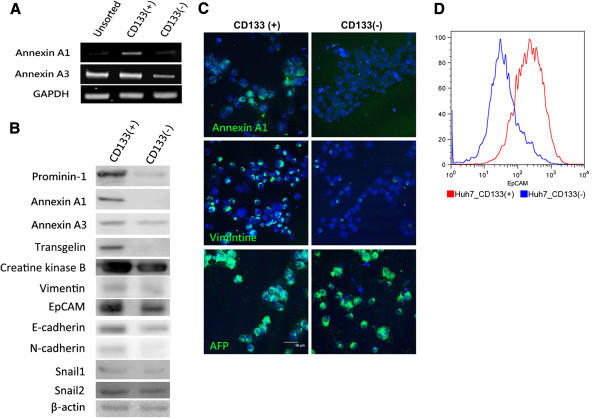
Validation of significantly up-regulated proteins in CD133+Huh7 and CD133-Huh7 cells. (A) RT-PCR, (B) western blot analysis, (C) immunofluorescent staining, and (D) FACS analysis were performed to validate significantly up-regulated proteins in CD133+ and CD133- Huh7 cells. GAPDH in the RT-PCR and β-actin in the western blot were used as loading controls.